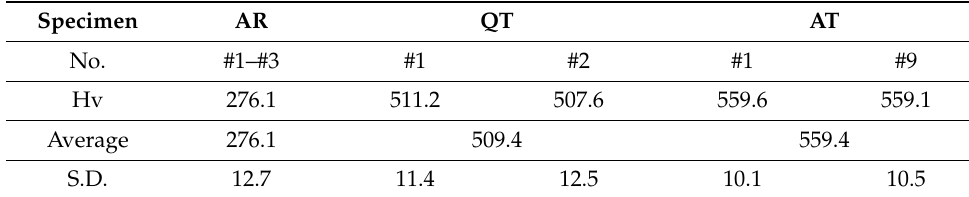
Table 3. Results of Vickers hardness test.